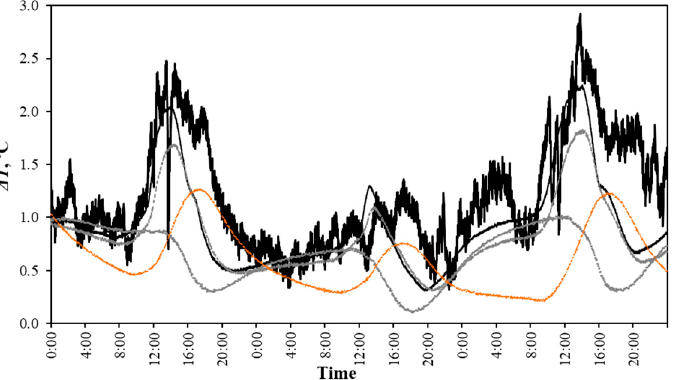
Figure 7. Difference in soil temperature with low tunnel and without low tunnel measured from the 3 to 5 March 2015: at 0 m ( ▬ ), 0.05 m ( ─ ), 0.10 m (---), 0.15 ( ··· ), and 0.20 m ( ··· ) depth.